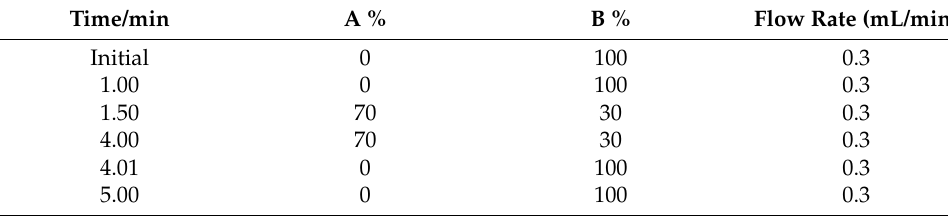
Table 3. UPLC-MS/MS liquid phase condition.